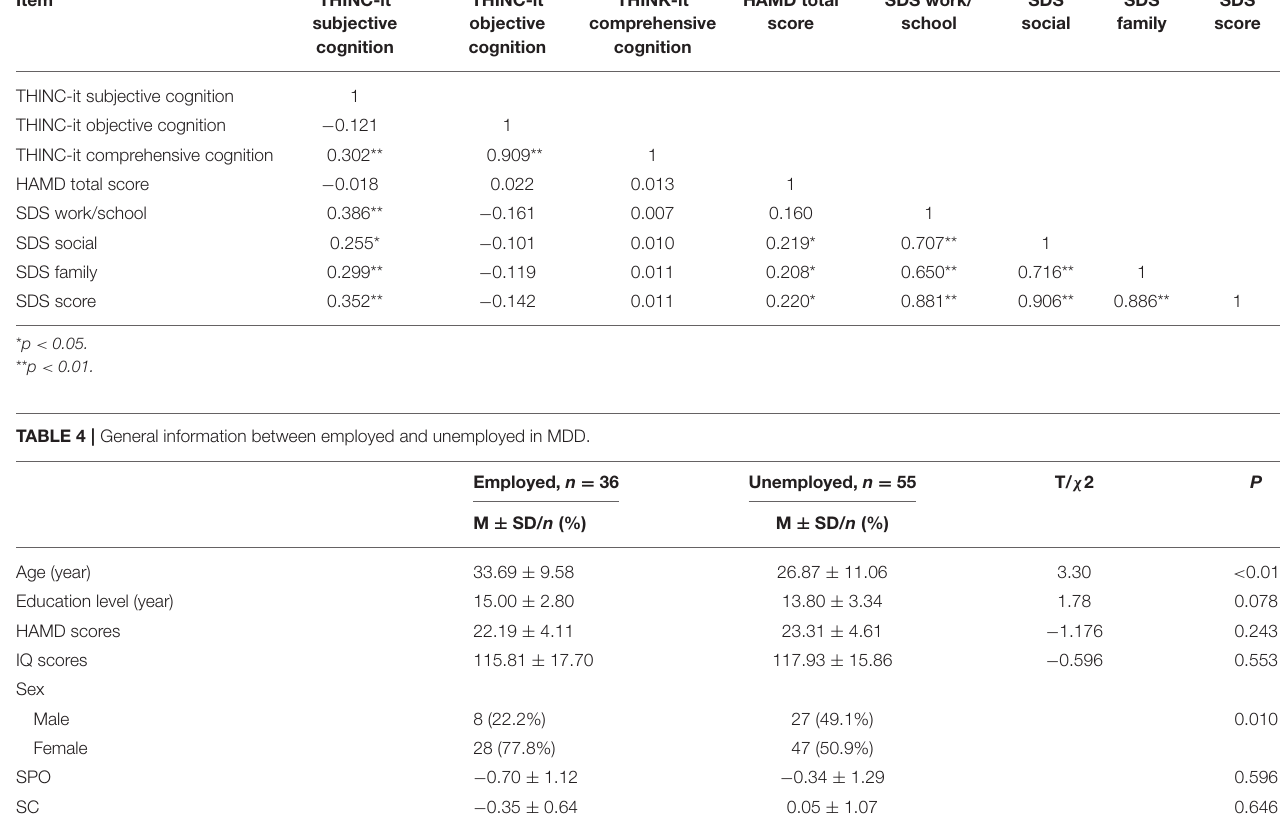
TABLE 3 | Correlation analysis in the degree of depression, cognitive function and social impairment. Item